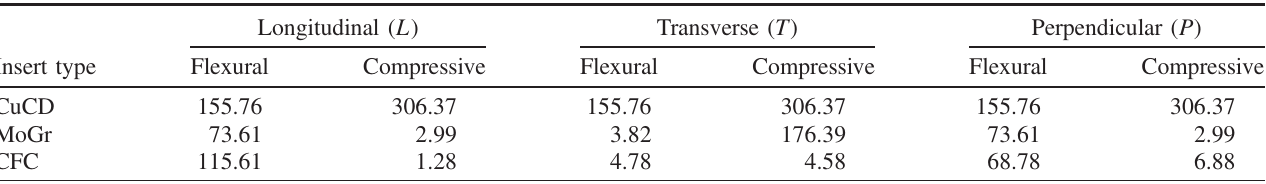
TABLE III. Flexural and compressive elastic moduli [GPa] along the respective orientations. Longitudinal ( L ) Transverse ( T ) Perpendicular ( P